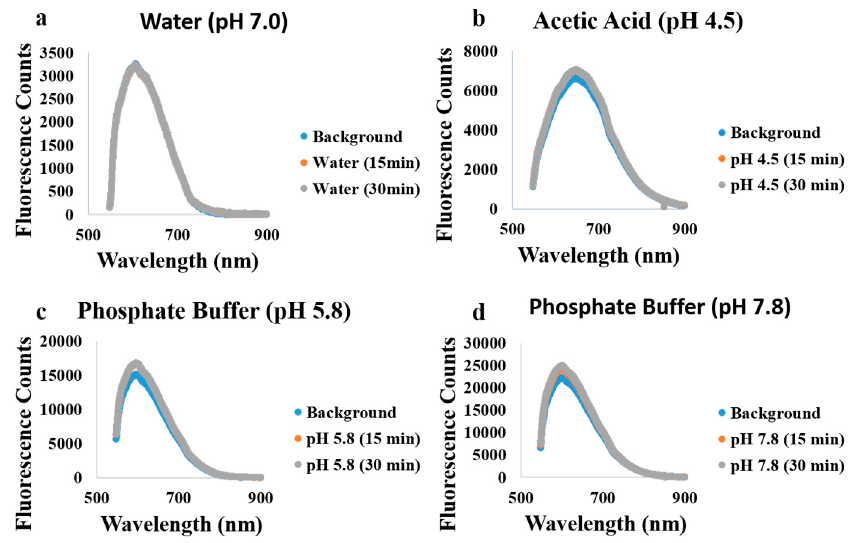
Figure 3. Fluorescence counts for a plasma polymerized ECF. Blue curve corresponds to auto fluorescence from the plasma polymer coating. Orange and grey curves correspond to auto fluorescence after exposure to different buffer solutions for 15 and 30 min respectively.